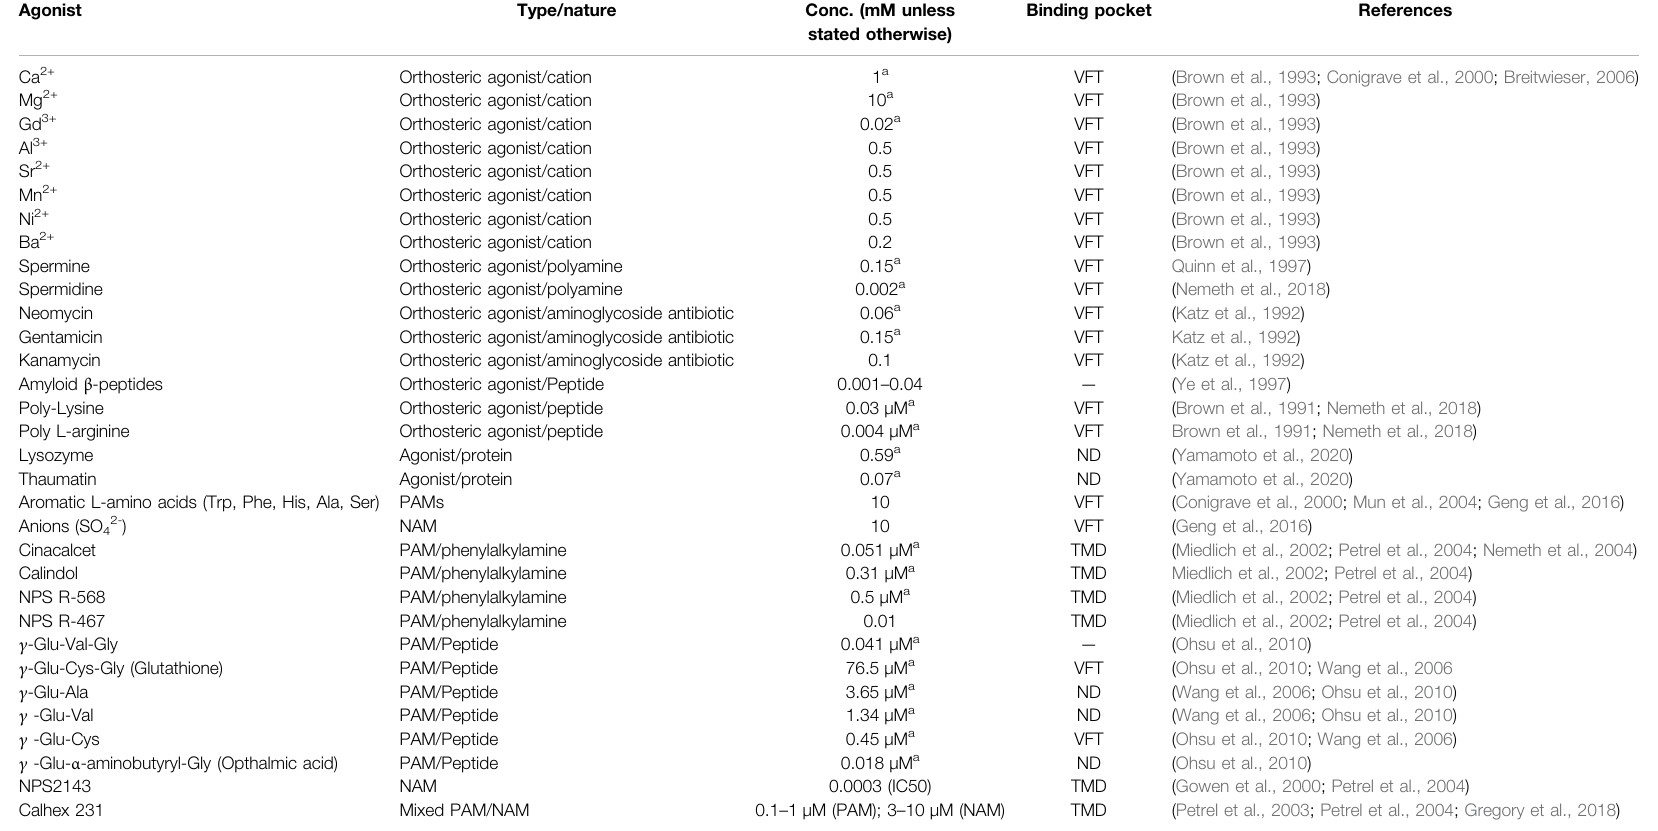
Where VFT, venus fl ytrap domain; TMD, transmembrane domain; ND, not determined. a shows EC50